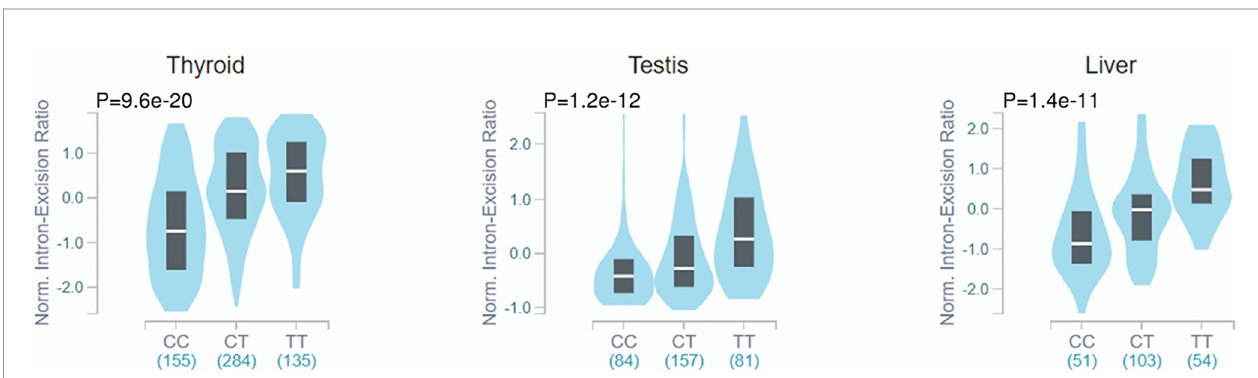
FIGURE 1 | Violin plots of intron-excision ratios across different human tissues according to rs10109853 genotypes in IDO2 (variant chr8_40005362_C_T_b38). Data were retrieved from the Genotype-Tissue Expression database (GTEx Analysis Release v8). The colored region indicates the density distribution of the samples in each genotype. The white line in the box plot indicates the median value of the intron excision ratio for each